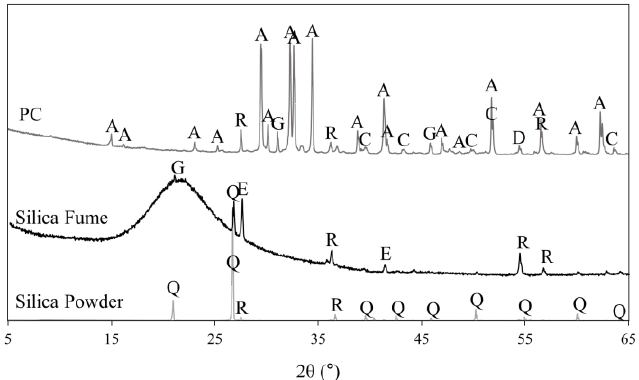
Figure 3. X-ray diffraction (XRD) patterns of binder (A: alite, C: calcite, D: dipotassium sulfate, E: ettringite, G: gypsum, Q: quartz, and R: rutile).